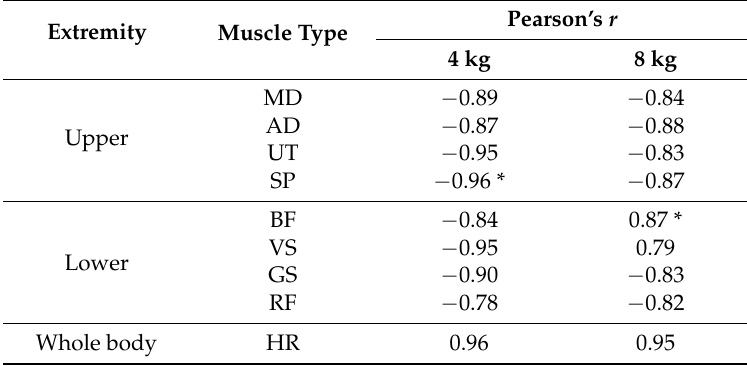
Table 3. Correlation of Borg’s scale ratings with the muscles of the upper and lower extremity and heart rate. Medial deltoid (MD), anterior deltoid (AD), upper trapezius, supraspinatus (SP), bicep femoris (BF) vastus laterals (VS), gastrocnemius (GS), rectus femoris (RF), and heart rate